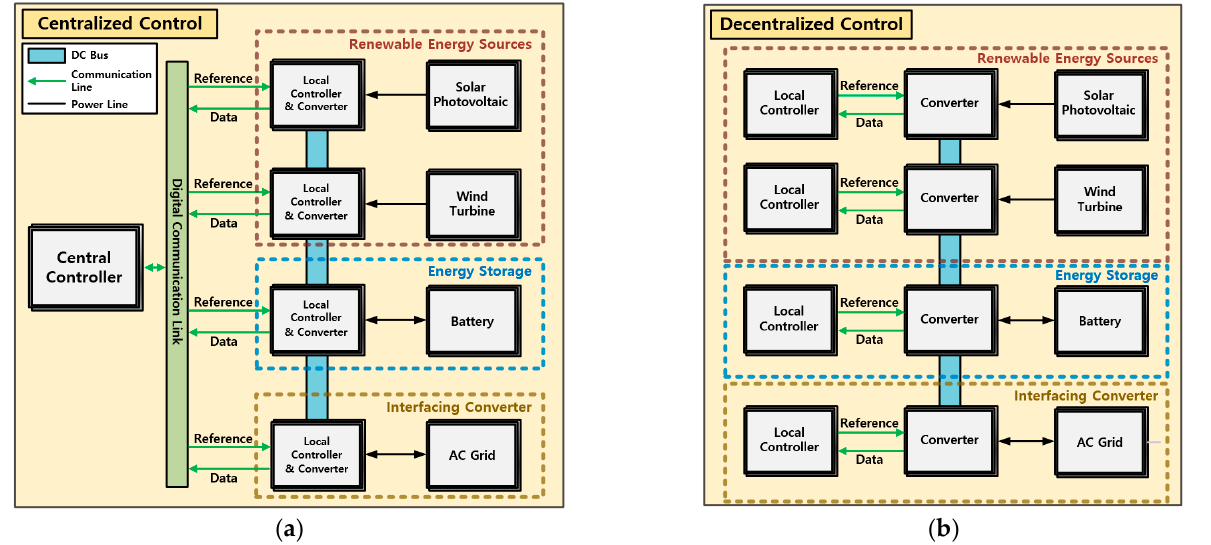
Figure 1. Control structure of DC microgrid ( a ) centralized control, ( b ) decentralized control.